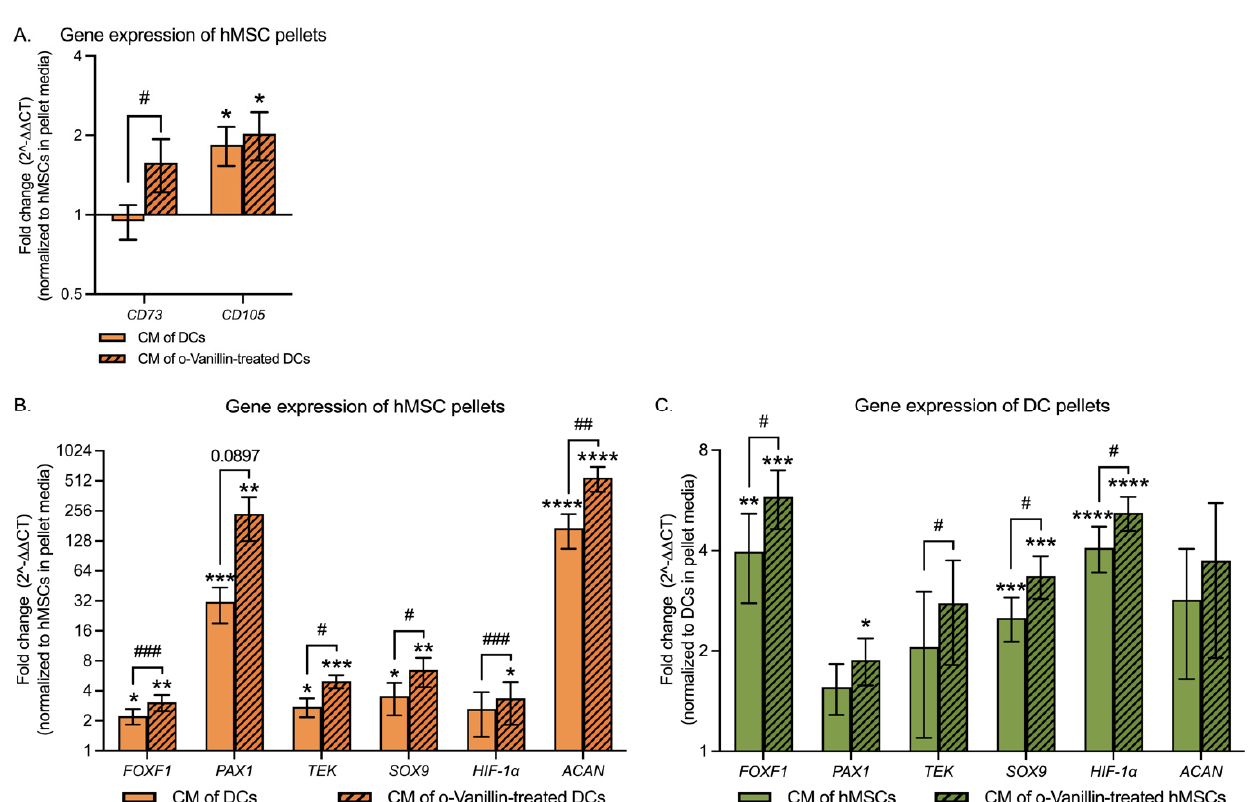
Figure 5. Gene expressions of hMSC and nucleus pulposus (NP) cell markers in hMSC and DC pellets with and without o-Vanillin treatment. ( A ) hMSC marker expressions in hMSC cultures exposed to CM of untreated and o-Vanillin-treated DCs. n = 8. ( B ) NP cell marker expressions in hMSC cultures exposed to CM of untreated and o-Vanillin-treated DCs. n = 8. ( C ) NP cell marker expressions in DC cultures exposed to CM of untreated and o-Vanillin-treated hMSCs. n = 8. Data were normalized to pellets cultured with regular pellet culture media and were not exposed to CM (control pellets). Values are presented as mean ± SEM. *, **, ***, and **** indicate a statistical significance of p < 0.05, p < 0.01, p < 0.001, and p < 0.0001, respectively, assessed by a paired t- test compared to the control pellets. #, ##, and ### indicate a statistically significant change of p < 0.05, p < 0.01, and p < 0.001 assessed by a paired t- test between untreated and o-Vanillin-treated pellets. The patterned histograms represent the group exposed to the CM of o-Vanillin-treated pellets. Additionally, see Table